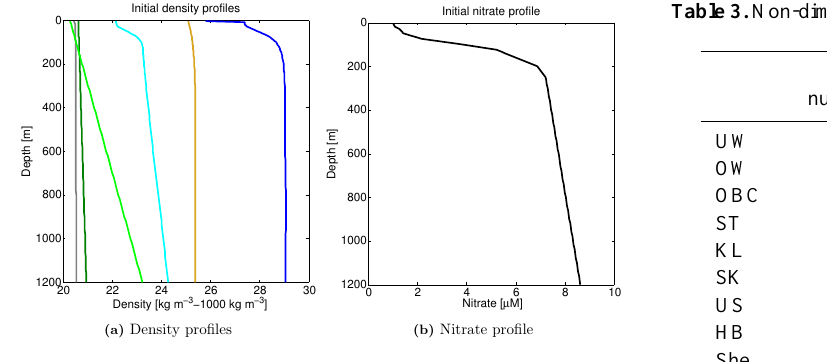
Figure 2. Initial (a) density and (b) nitrate profiles for all model simulations. In the density profiles, grey represents SK and SHR; green represents KL and US; light green represents HB, LRC, and KHRB; light blue represents BLRB; brown represents She; and blue represents UW, OW, OBC, ST, and SF. Simulation abbreviations are explained in Sect. 2.4.